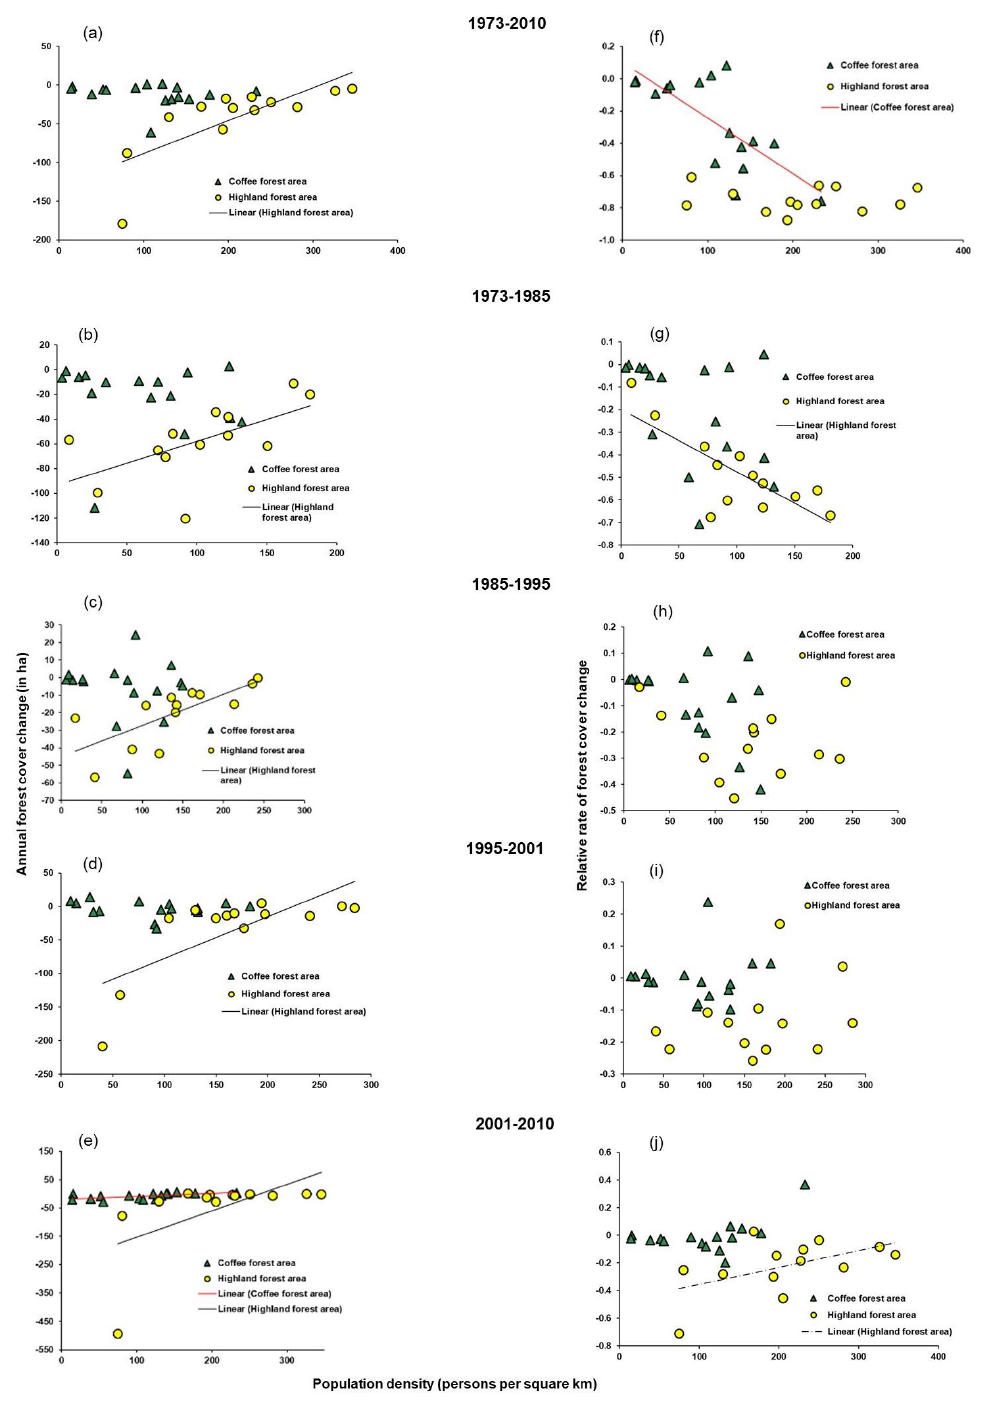
Figure 3. Correlation between forest cover changes (area and relative) and population density in kebeles in co ff ee and highland forest areas of Gera. Chira town is not included in the graph and statistical test for which the p -values are reported. The linear trend lines are included where the p -values for Spearman’s rank correlation tests are < 0.05 (solid) and 0.067 (dotted). The y-values are forest cover changes (area, a – e ; relative, f – j ) during 1973–2010, 1973–1985, 1985–1995, 1995–2001, and 2001–2010, while the x-values are population densities in 2010 ( a , e , f , j ), 1985 ( b , g ), 1995 ( c , h ), and 2001 ( d , i ) for the kebeles in co ff ee and highland forest